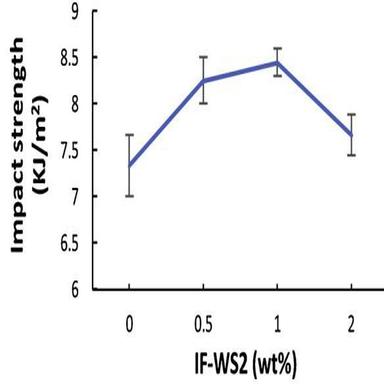
Impact strength of PEEK samples containing various amounts of IF-WS2.